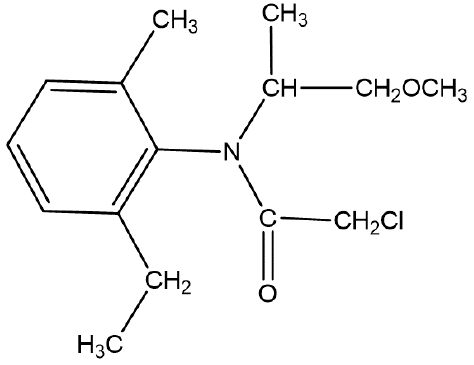
Figure 1. Chemical structure of metolachlor.